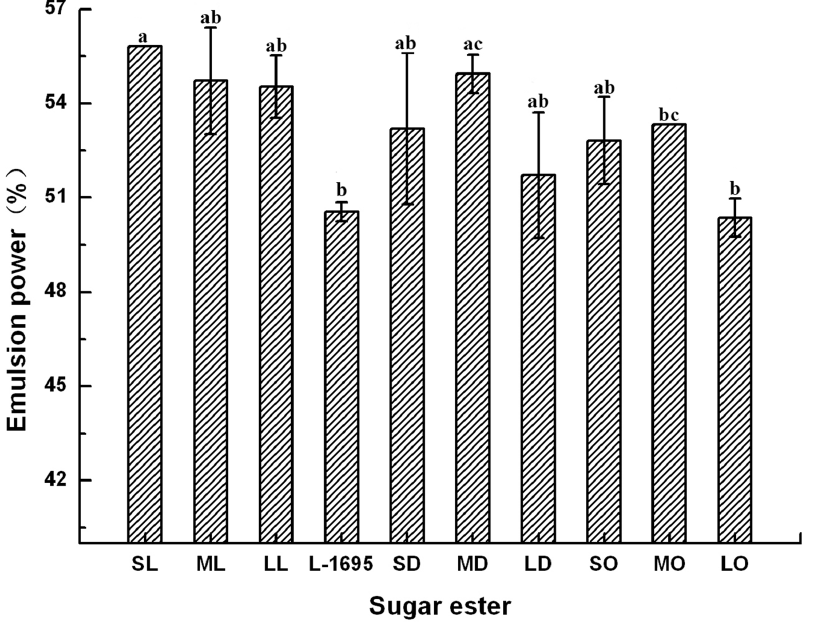
Fig. 3. The foaming stability of sugar monolaurates of different concentrations and standing times: (a) SL; (b) ML; (c) LL.